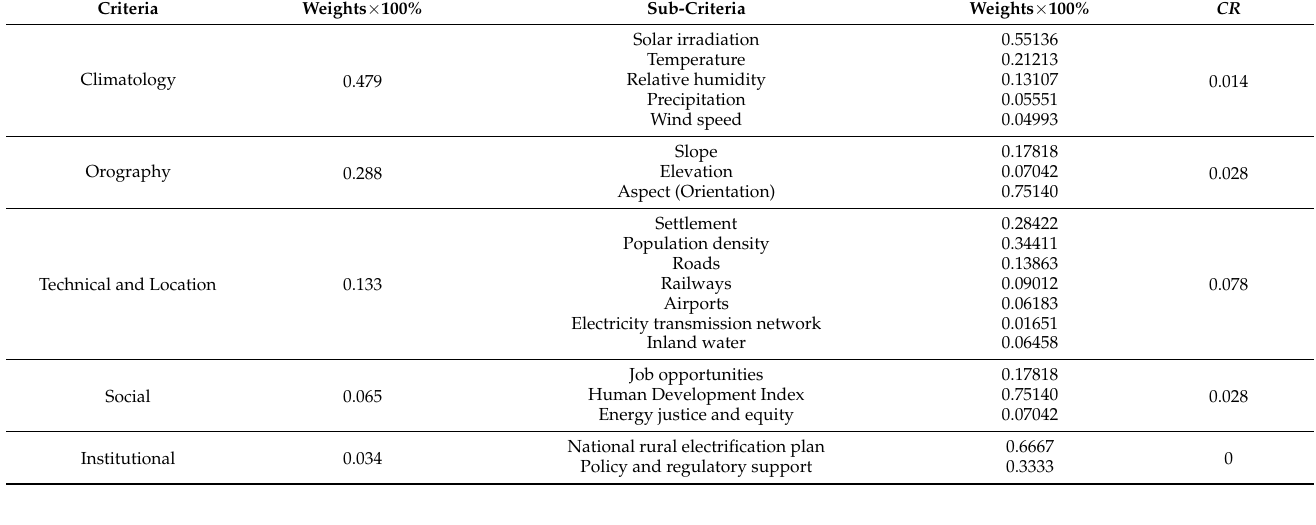
Table 8. Criteria and sub-criteria priority weights obtained from authors’ and experts’ judgments.